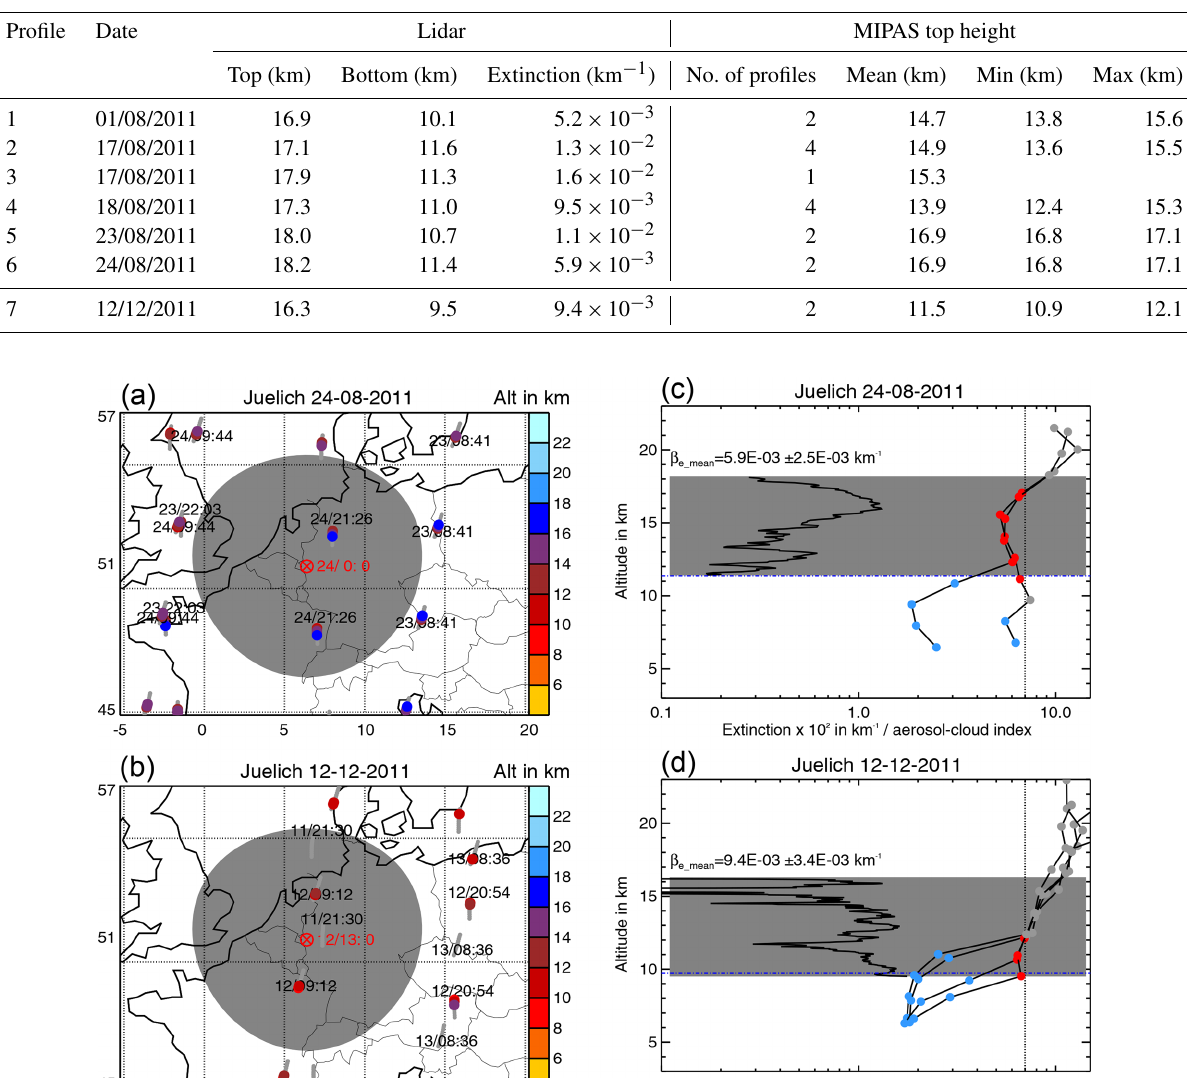
Table 7. Nabro sulfate aerosol measured by the Jülich lidar and MIPAS. For the lidar data aerosol layer top, bottom, and mean extinctions at 355nm are given. For MIPAS, the number of matching profiles, the mean cloud top height, and the corresponding minimum and maximum top heights are given.